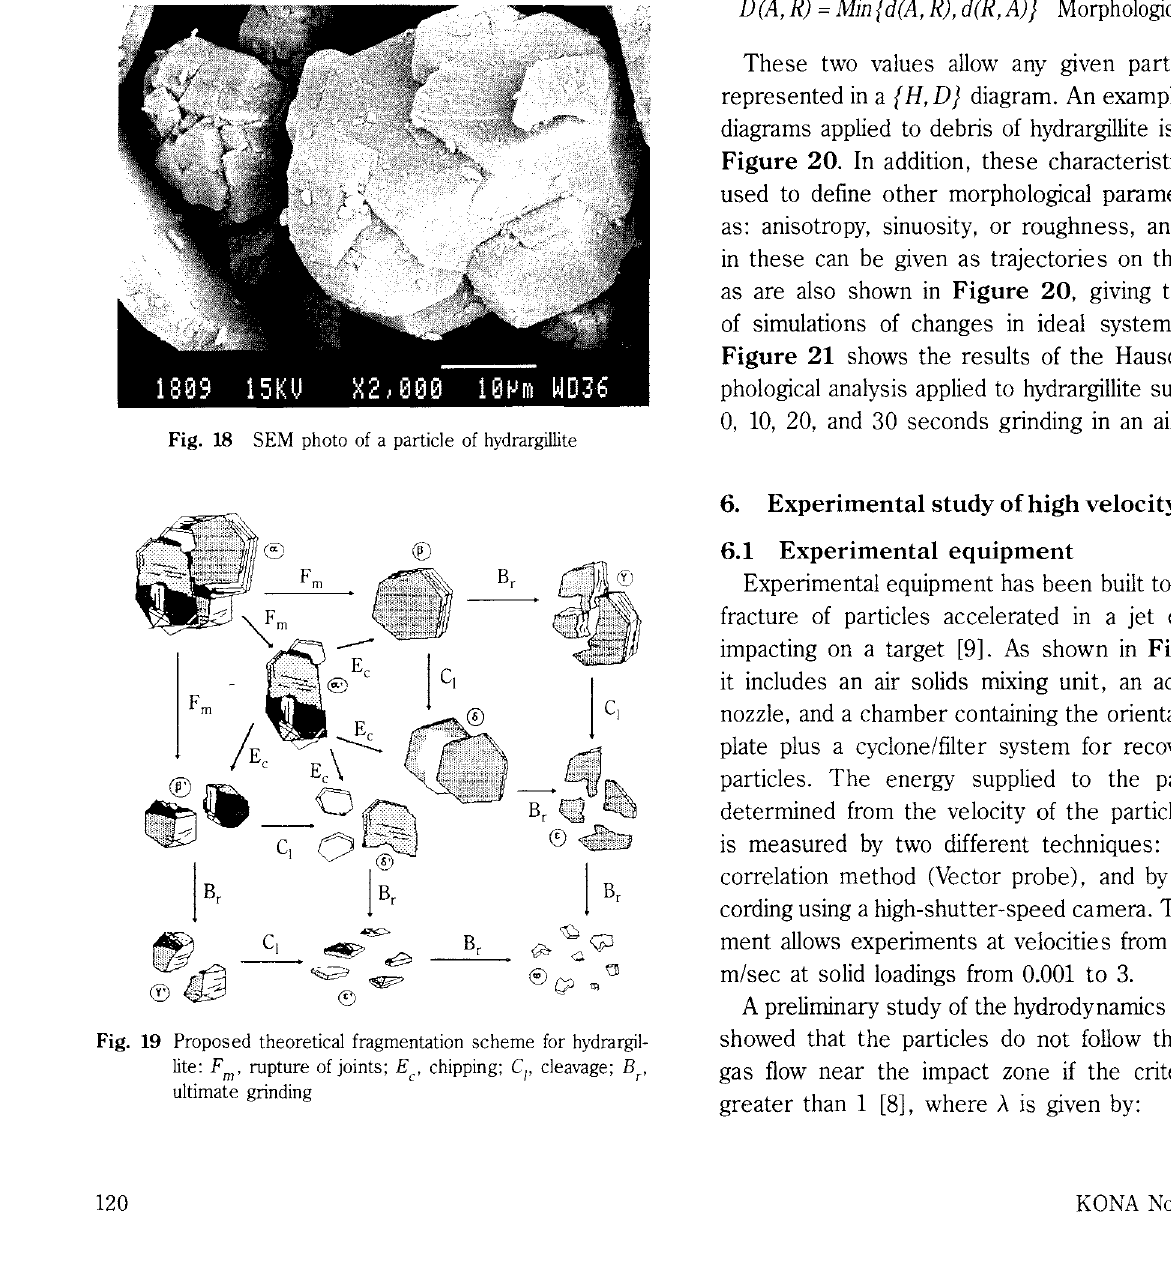
Fig. 19 Proposed theoretical fragmentation scheme for hydrargil lite: Fm, rupture of joints; Ec, chipping; C 1, cleavage; B,, ultimate